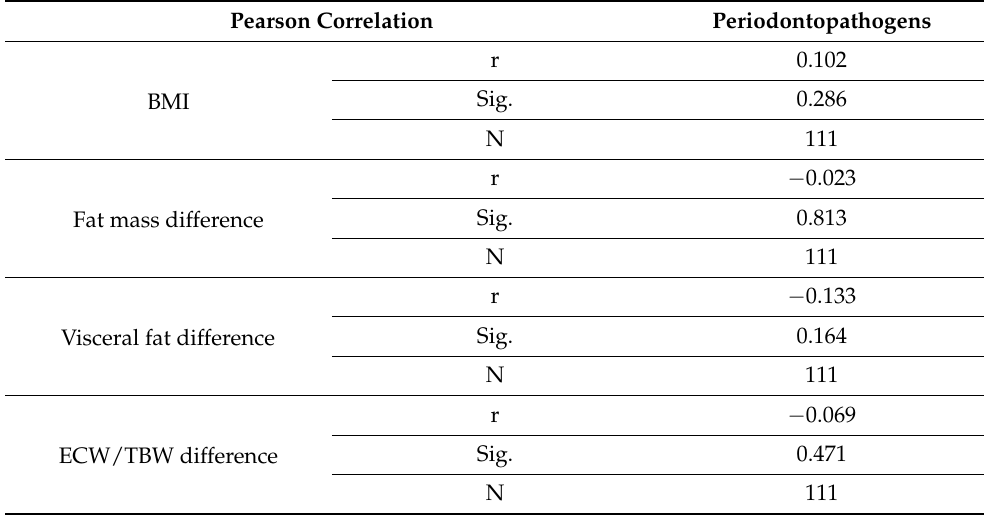
Table 5. Pearson correlation between periodontal disease and ECW/TBW fat mass in the cohort. Pearson